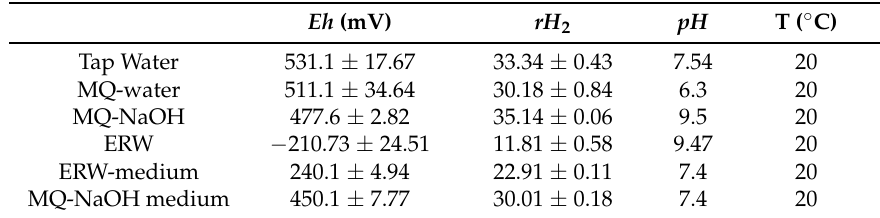
Table 1. Physicochemical parameters of Tap water, MQ water, ERW and MQ-water containing NaOH 2 mM. Values are expressed as mean ± SD.